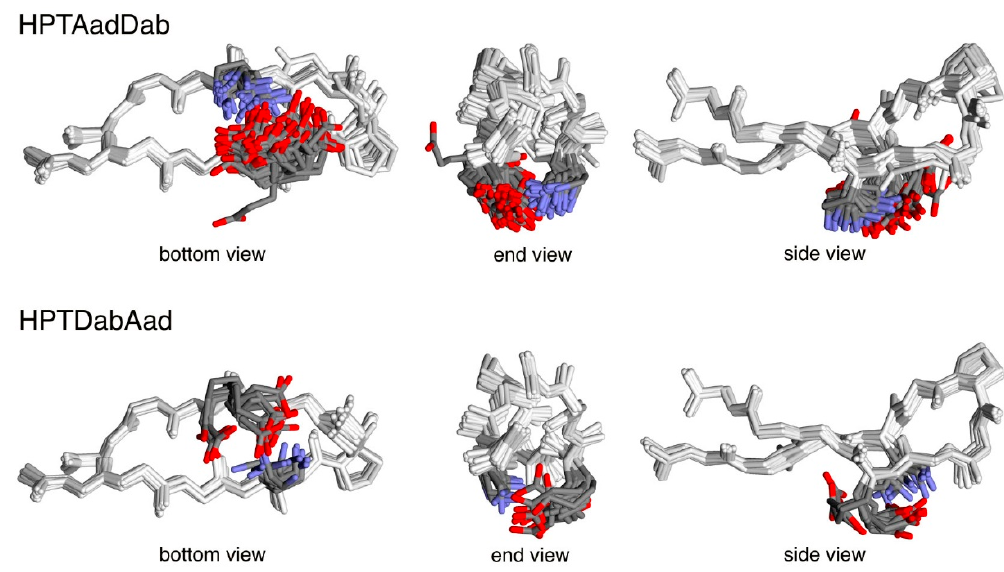
Figure 3. The low-energy conformations from molecular mechanics calculations for peptides HPTAadDab and HPTDabAad. The backbone and DPro side-chain are shown in white. The residues at positions 4 and 9 are colored according to element: carbon in gray, oxygen in red, and nitrogen in blue. The other side-chains and all hydrogen atoms are omitted for clarity.